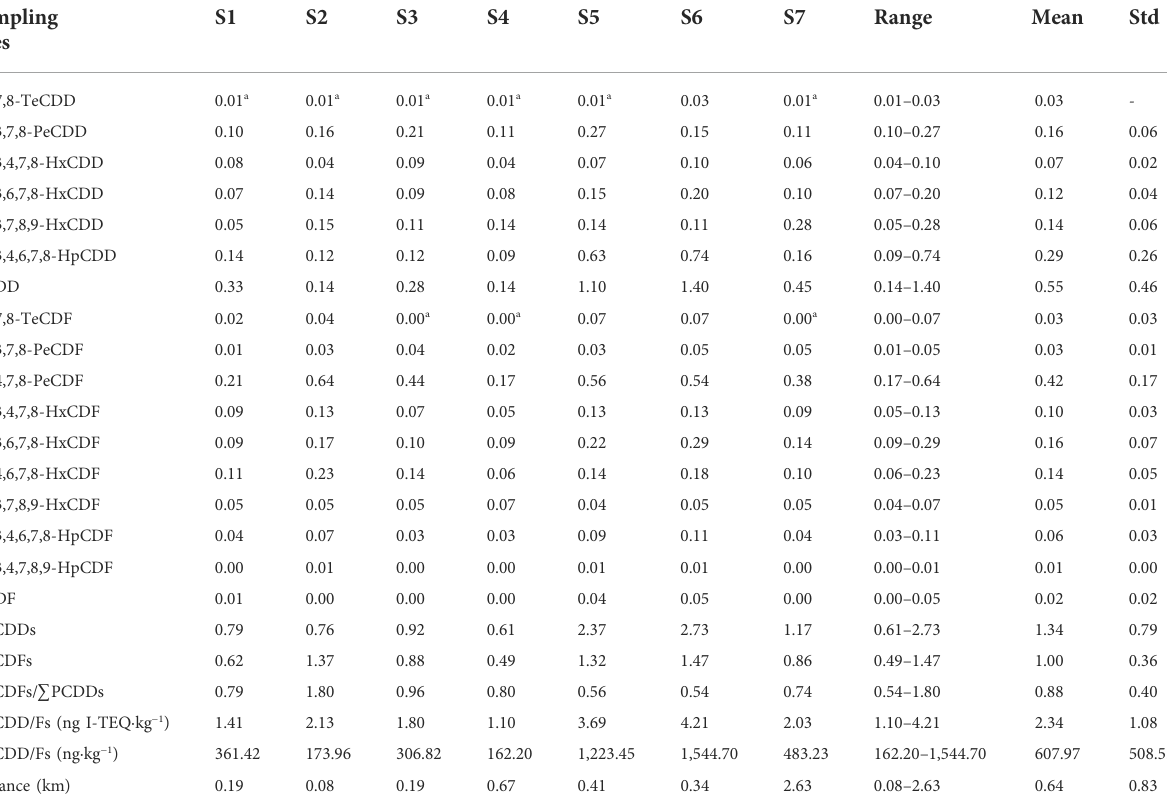
TABLE 1 I-TEQ values (unit: ng I-TEQ · kg − 1 , dry weight) and concentrations (unit: ng · kg − 1 , dry weight) of dioxins in the surface soil around the studied MSW incinerator. Sampling sites